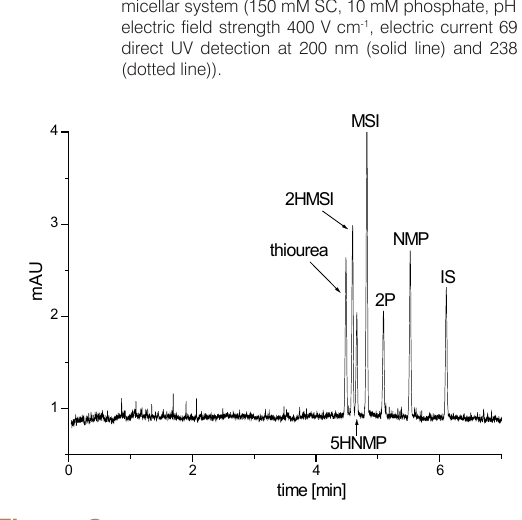
Figure 3. Electropherogram of NMP and its metabolites (10 mg L -1 each in diluted rat urine) under selected conditions (140 mM SDS, 5 mM phosphate, pH 7.1, electric field strength 400 V cm -1 , electric current 44 µA, direct UV detection at 200 nm). IS is 5-methyl-2-